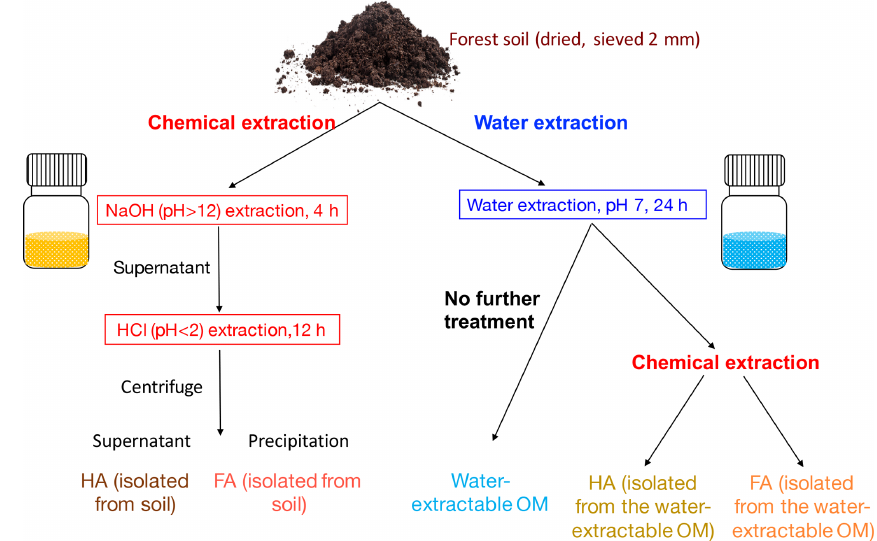
Figure 1. Schematic diagram of the soil organic matter (SOM) extraction process. Forest soil samples (Schönbuch forest, Baden- Württemberg, Germany) were dried under 30 ◦ C and ground to pass through a 2mm sieve. To isolate FA and HA from soil, 100g of soil was incubated with 400mL 0.1MNaOH (pH 12) for 4h; after centrifugation, the supernatant was acidified by HCl to pH < 2. HA was then precipitated out to be separated from FA, and we define these two extracts as HA (isolated from soil) and FA (isolated from soil). For water extraction, 100g of soil was incubated with 400mL ultrapure water ( < 18 . 2M (cid:127) cm; Milli-Q, Millipore) at a pH of 7. pH was monitored during the extraction and it remained stable (range between 7.02 and 7.33). The slurry was centrifuged after 24h; we define the supernatant as water-extractable OM. A 200mL aliquot of the supernatant containing the water-extractable OM was amended with 1MNaOH until a pH of 12. After 4h of incubation, the pH of the solution was adjusted to < 2 by 6MHCl to precipitate HA and to separate FA, and these two fractions are HA (isolated from water-extractable OM) and HA (isolated from water-extractable OM). All of the extractions were conducted under both oxic and anoxic